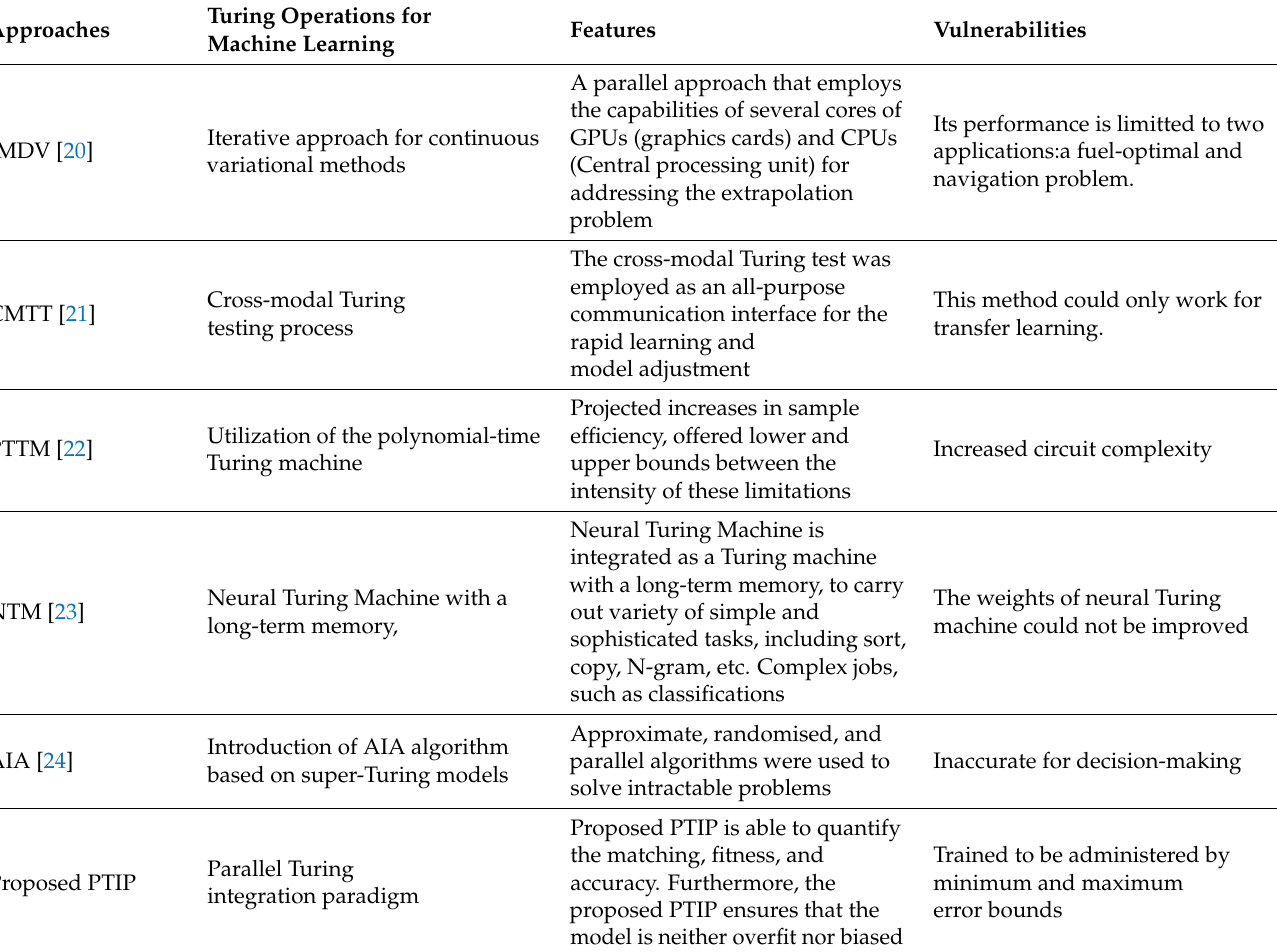
Table 1. Contemporary contributions of existing